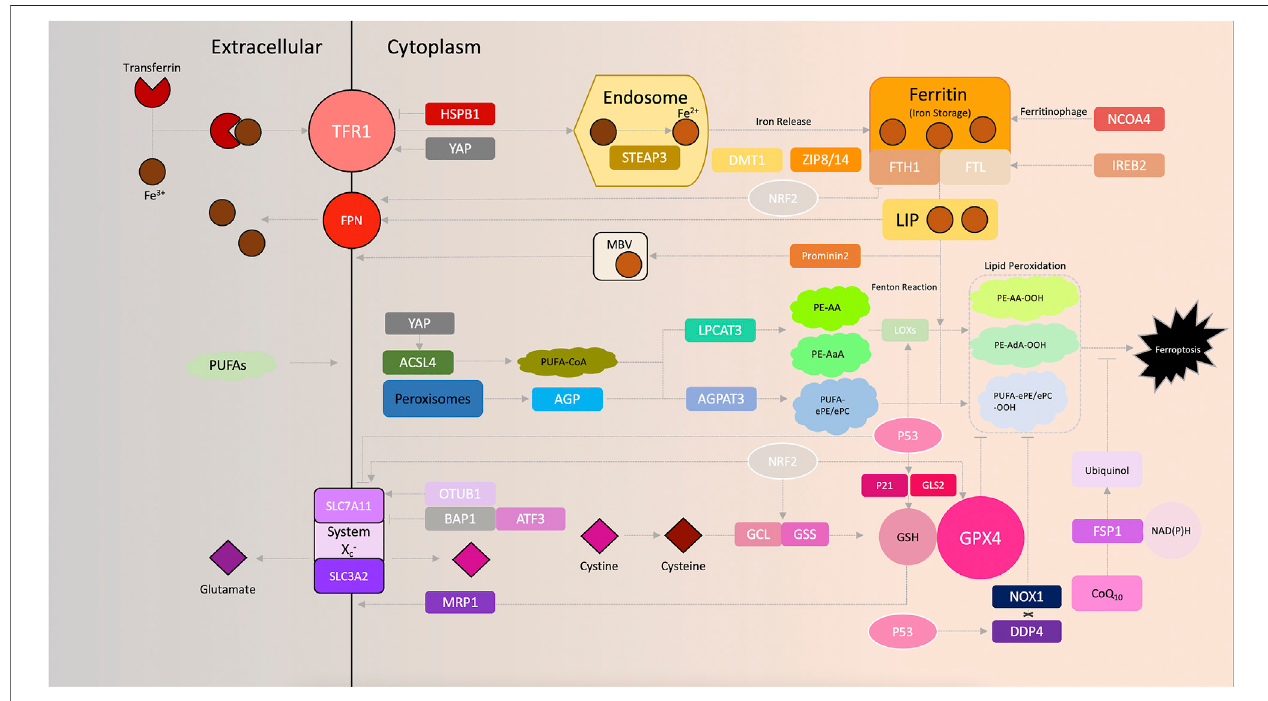
FIGURE 1 | Schematic of ferroptosis